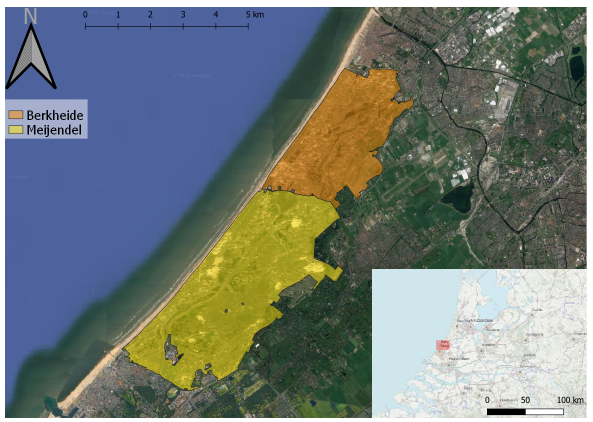
Figure 1. Berkheide en Meijendel dune area next to the city of The Hague, The Netherlands